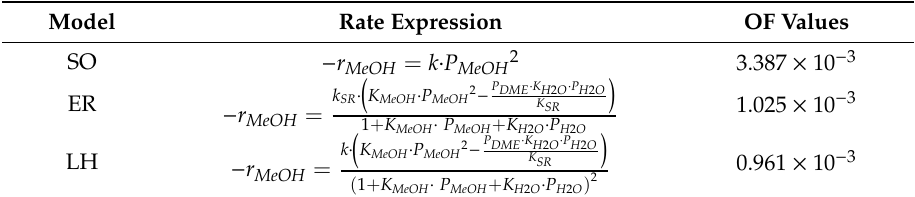
Table 3. Kinetic rate expressions for the methanol